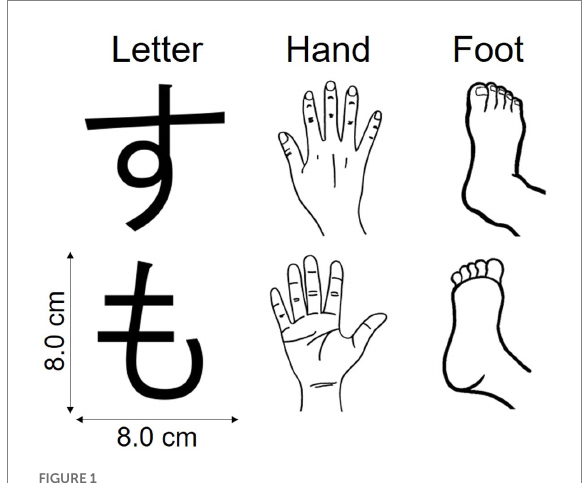
FIGURE 1 Stimuli used in the mental rotation task. These pictures and their mirrored counterparts were presented at 45 ° , 90 ° , and 135 ° , clockwise and